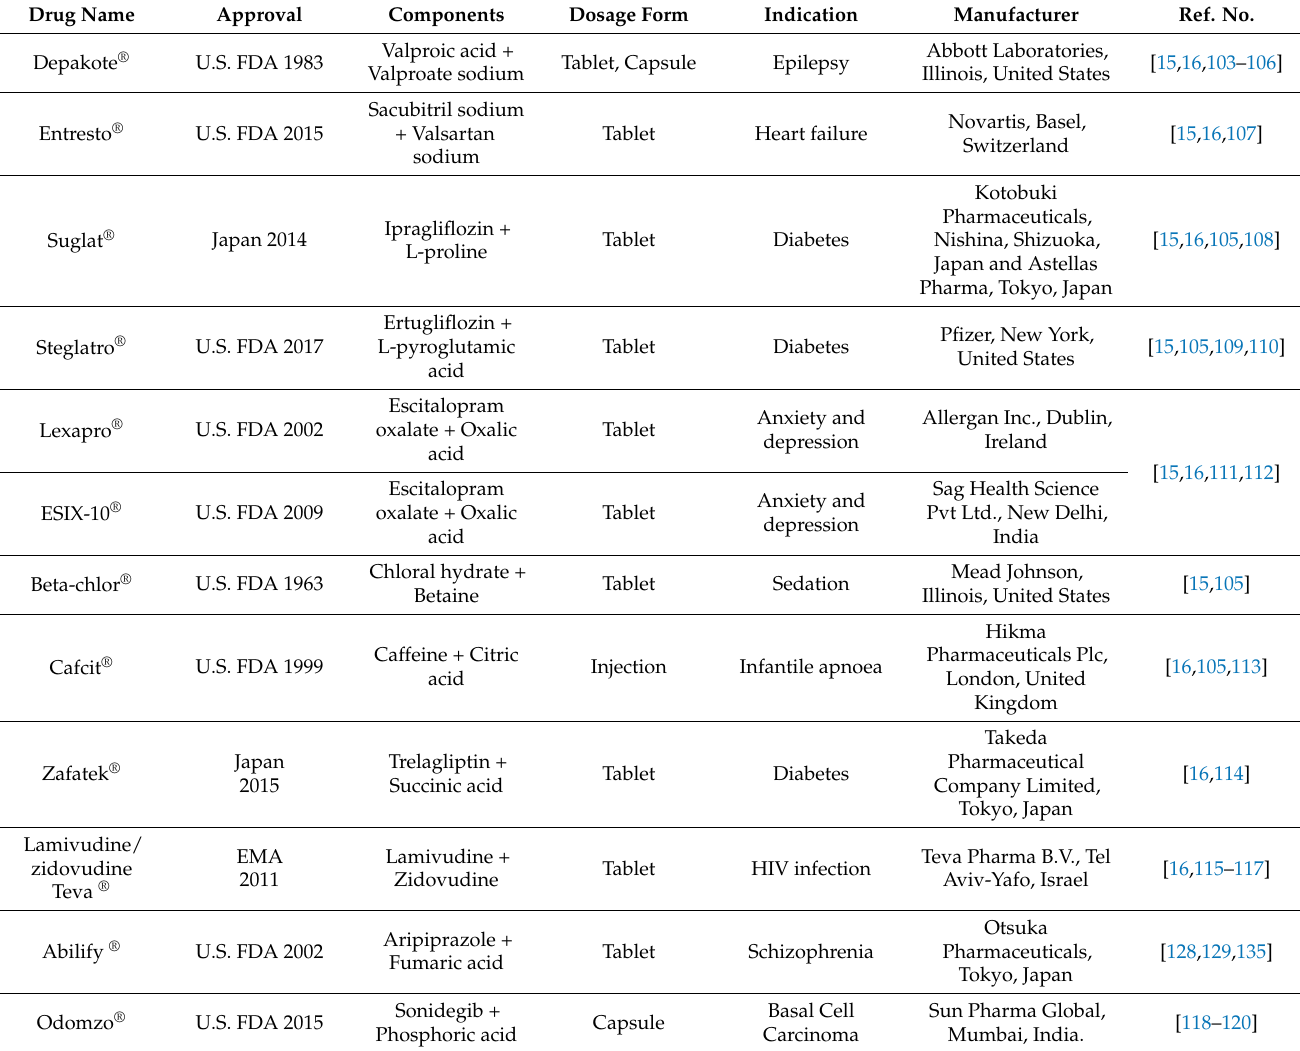
Table 6. List of commercialized